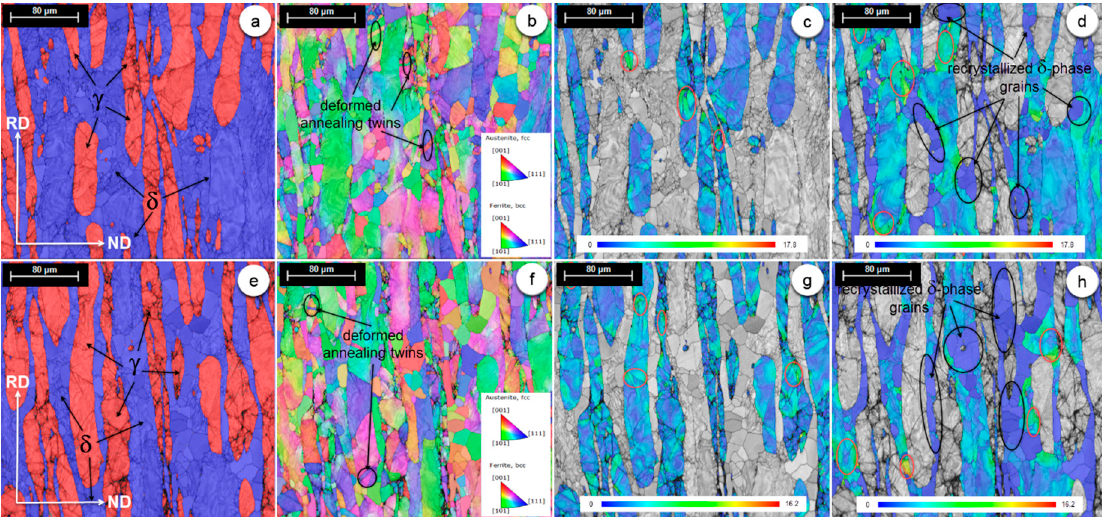
Figure 5. Distribution maps of both the γ - and δ -phases ( a ), inverse pole figure (IPF) ( b ), GROD map of the γ -phase ( c ) and δ -phase ( d ) for the short-duration aging treatment ( A1.1 ) state; distribution maps of both the γ - and δ -phases ( e ), inverse pole figure (IPF) ( f ), GROD map of the γ -phase ( g ) and δ -phase ( h ) for the long-duration aging treatment ( A1.2 ) state.